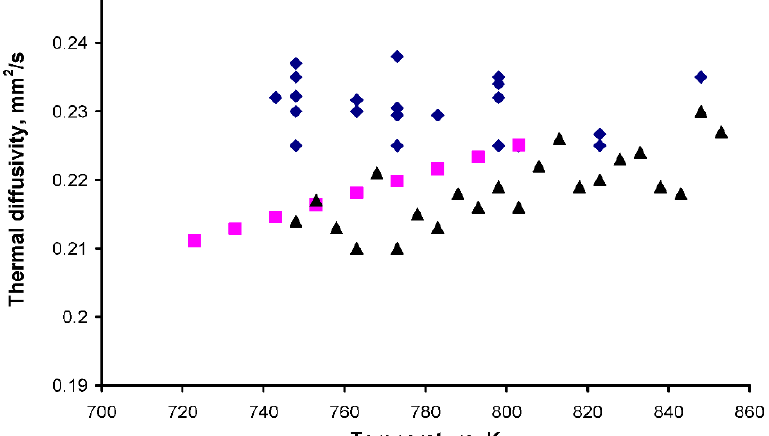
Figure 3. Thermal diffusivity data for FLiNaK: Our result ( ⯁ ), Kato ( ■ ), Robertson ( ▲ ).